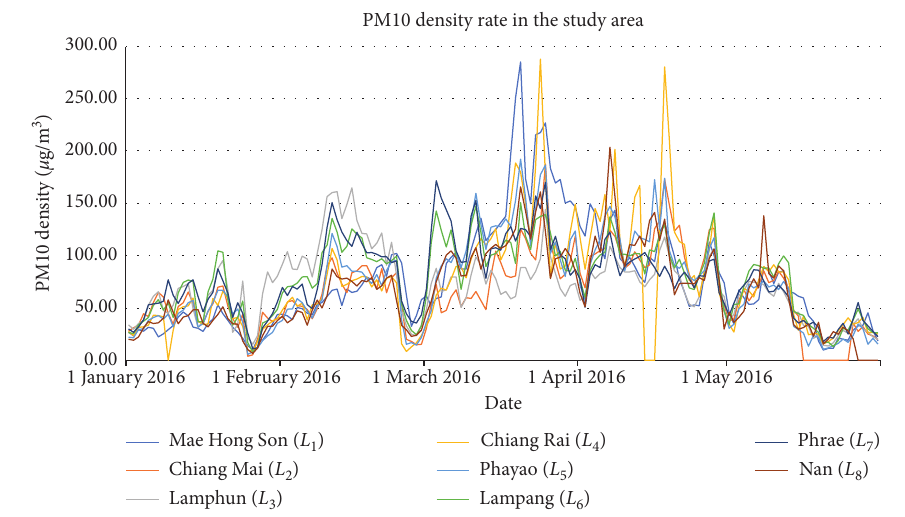
Figure 2: PM10 density rate of the eight selected locations from 1 st January 2016 to 31 st May